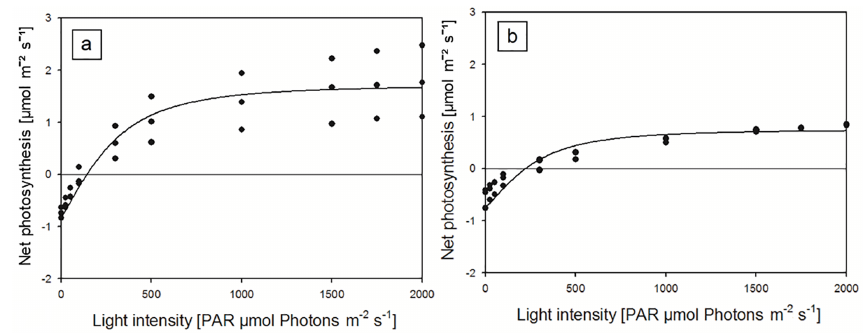
Figure 2. Light-dependent photosynthetic response curves of intact BSC with (a) C-BSC all and (b) G-BSC all ; n = 3; PAR = photosynthetic active radiation.